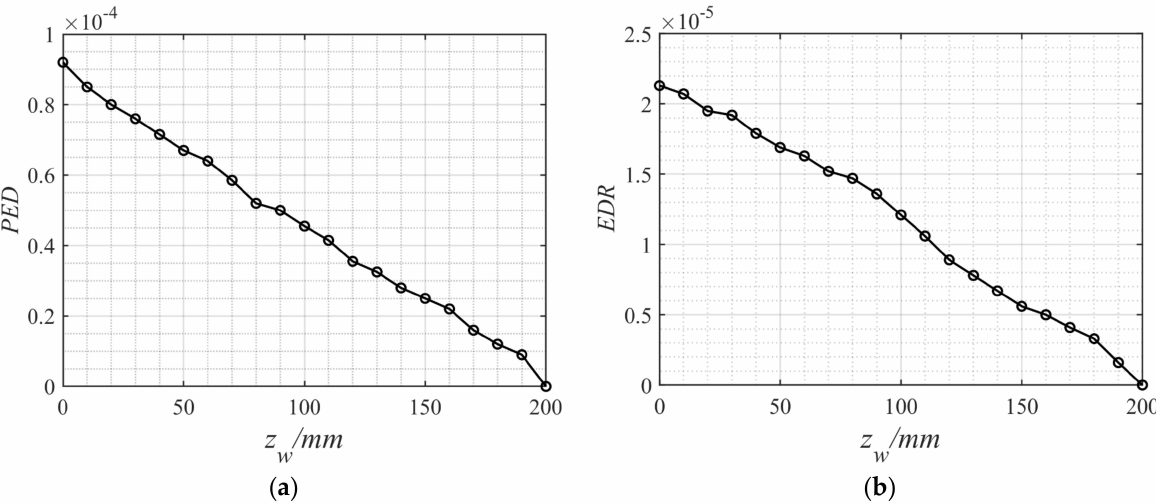
Figure 14. ( a ) PED for receiving planes of different heights; ( b ) EDR for receiving planes of different heights.